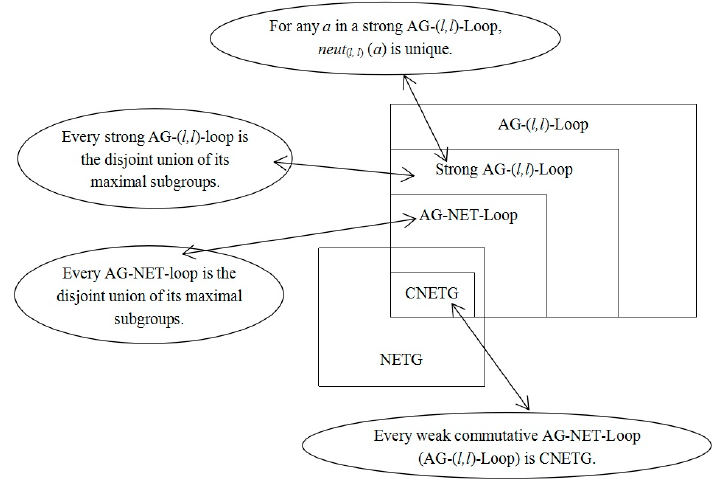
Figure 3. The main results of this paper.